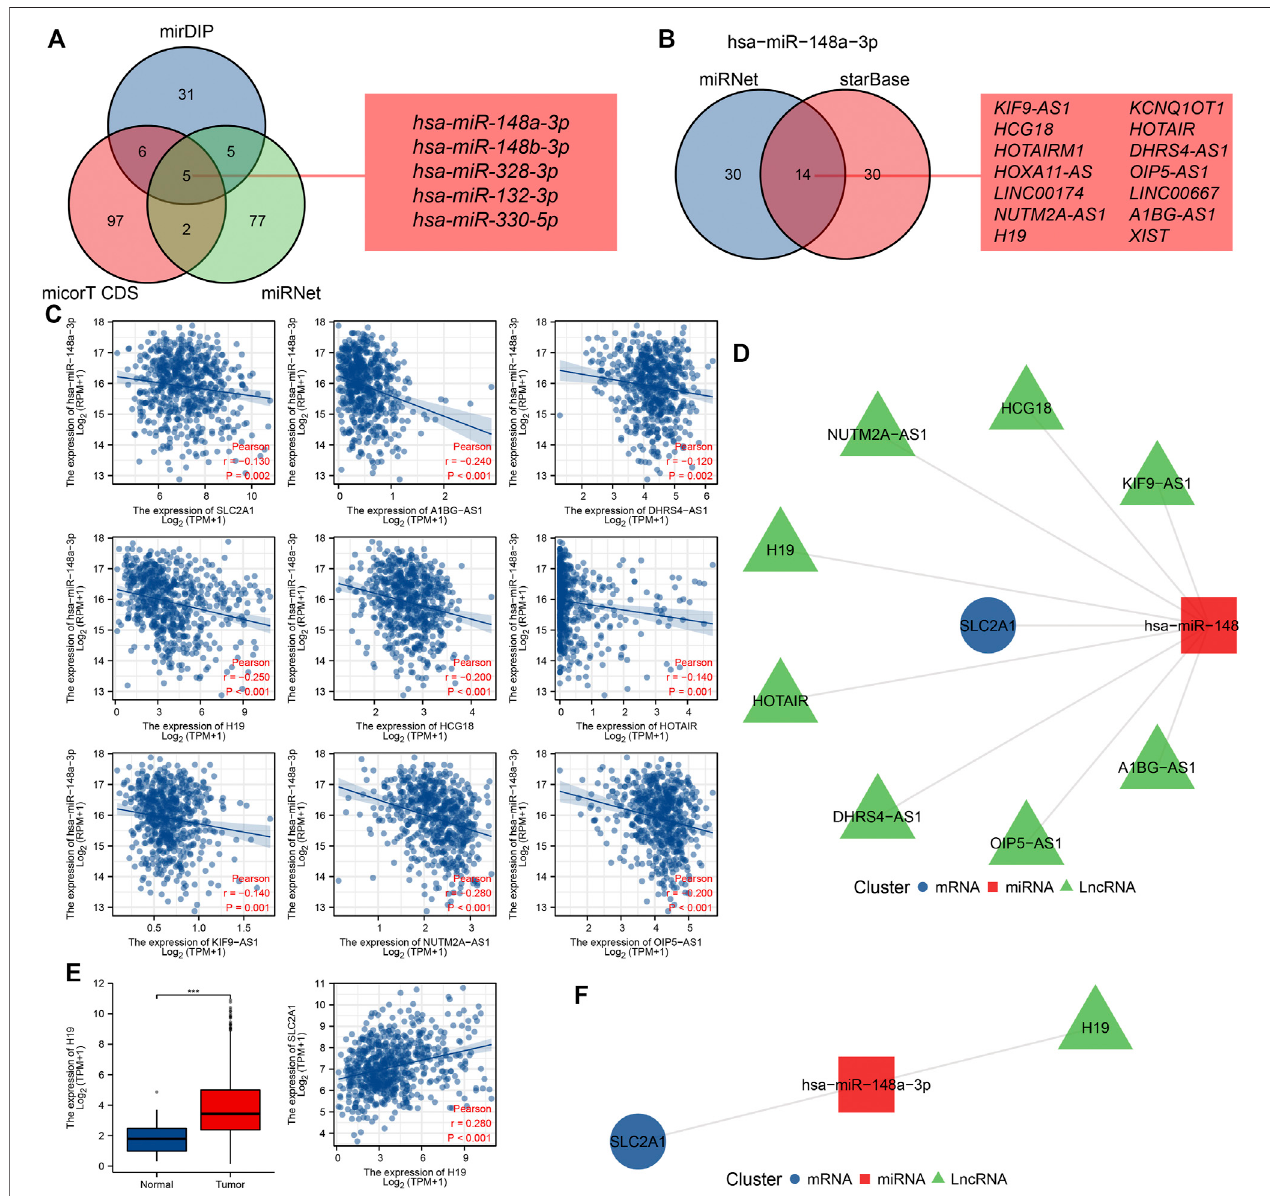
FIGURE 9 | Prediction and construction of SLC2A1 ceRNA network in colorectal cancer (CRC). (A) The Venn database displays miRNA of targeted SLC2A1 predicted by the mirDIP, micorT CDS, and miRNet tools. (B) The Venn database displays lncRNA of targeted hsa-miR-148a-3p predicted by the miRNet and starBase tools. (C) Scatterplotsshowresultswithexpressionalcorrelations,includingSLC2A1andhsa-miR-148a-3p,hsa-miR-148a-3pandAKIF9-AS1,hsa-miR-148a-3pand DHRS4-AS1, hsa-miR-148a-3p and H19, hsa-miR-148a-3p and HCG18, hsa-miR-148a-3p and HOTAIR, hsa-miR-148a-3p and KIF9-AS1, hsa-miR-148a-3p and NUTM2A-AS1, and hsa-miR-148a-3p and OIP5-AS1. (D) The network diagram shows the relationship of the predicted ceRNA network. (E) Only H19 was highly expressed in CRC and positively associated with SLC2A1 expression. (F) The network diagram shows the relationship of the fi nal ceRNA network.